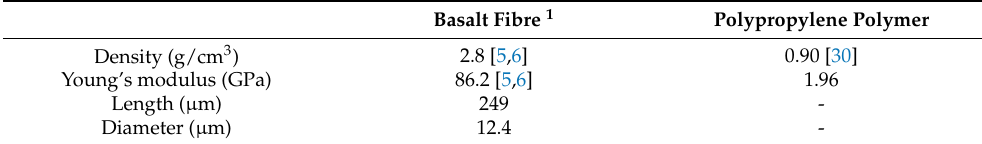
Table 7. Parameters used for analytical modelling of Young’s modulus.